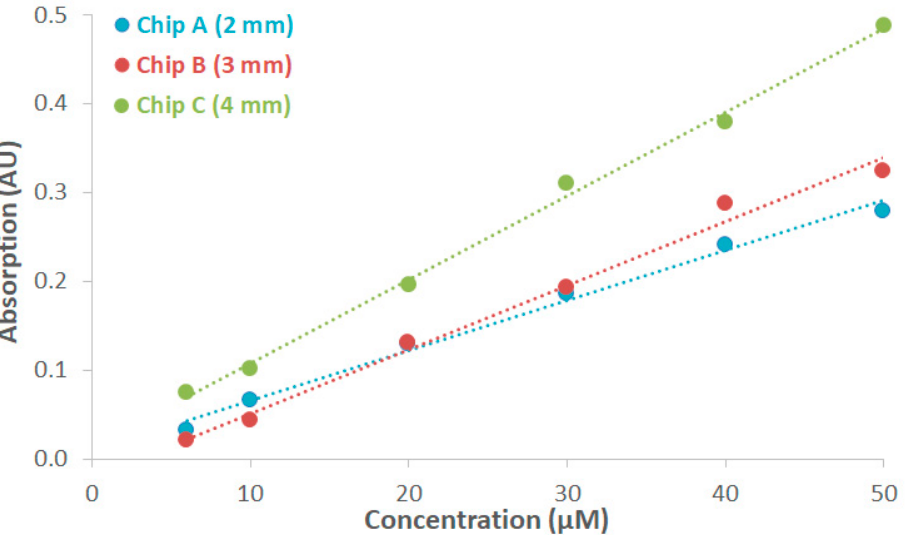
Figure 4. Absorption measurement curves of the absorption of Allura Red in chips A, B, and C versus the concentration at a wavelength of 504 nm.